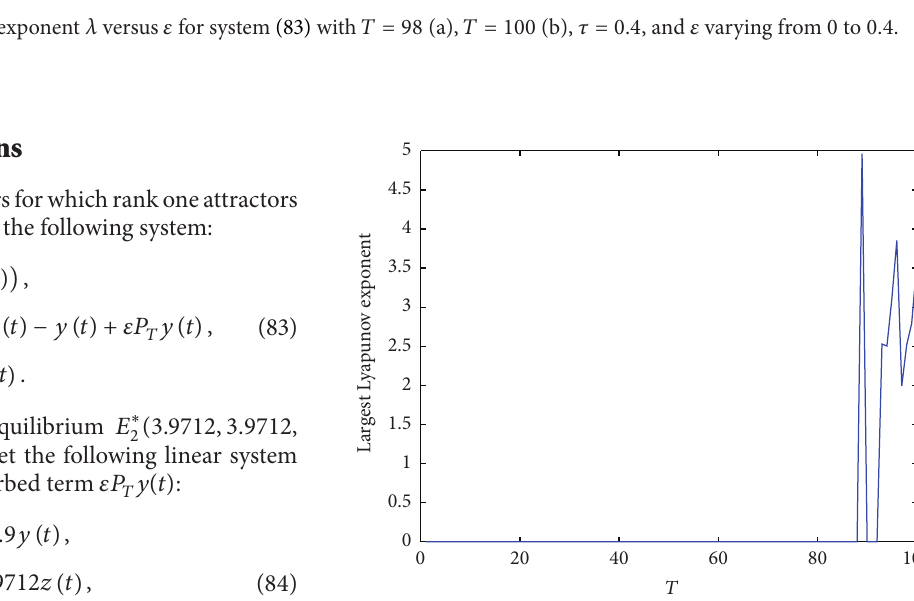
Figure 6: Largest Lyapunov exponent 𝜆 versus 𝑇 for system (83) with 𝜀 = 0.326 , 𝜏 = 0.4 , and 𝑇 varying from 0 to